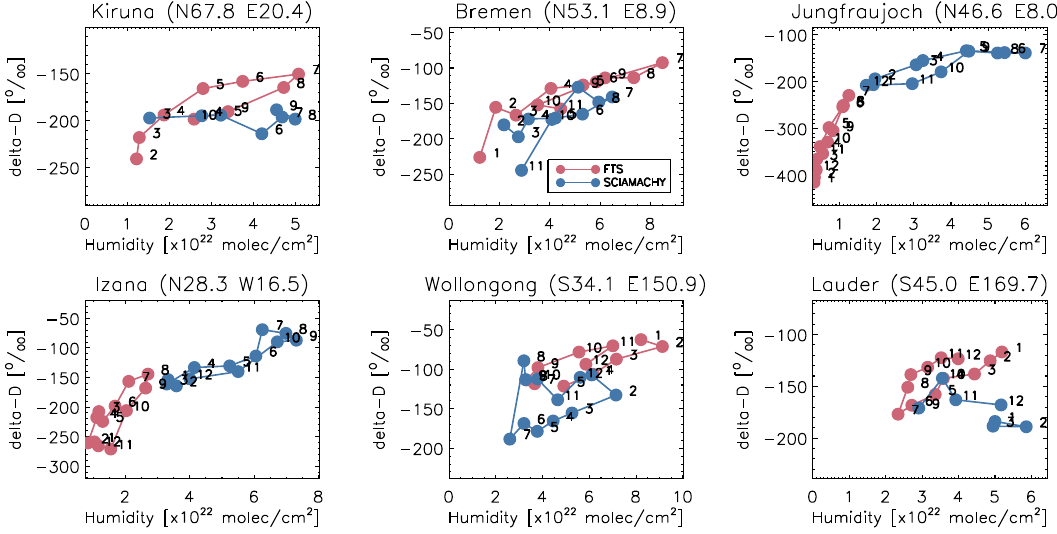
Figure 13. Same as Fig. 12 but for the MUSICA